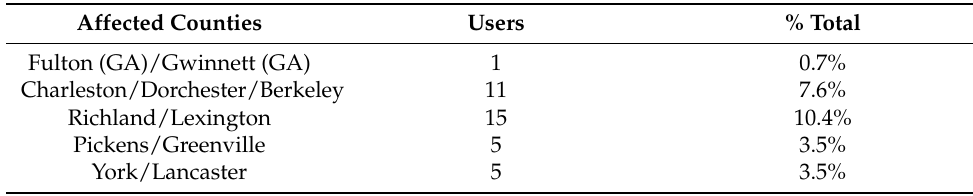
Table 2. Issues identified during the analysis of home location misidentifications.